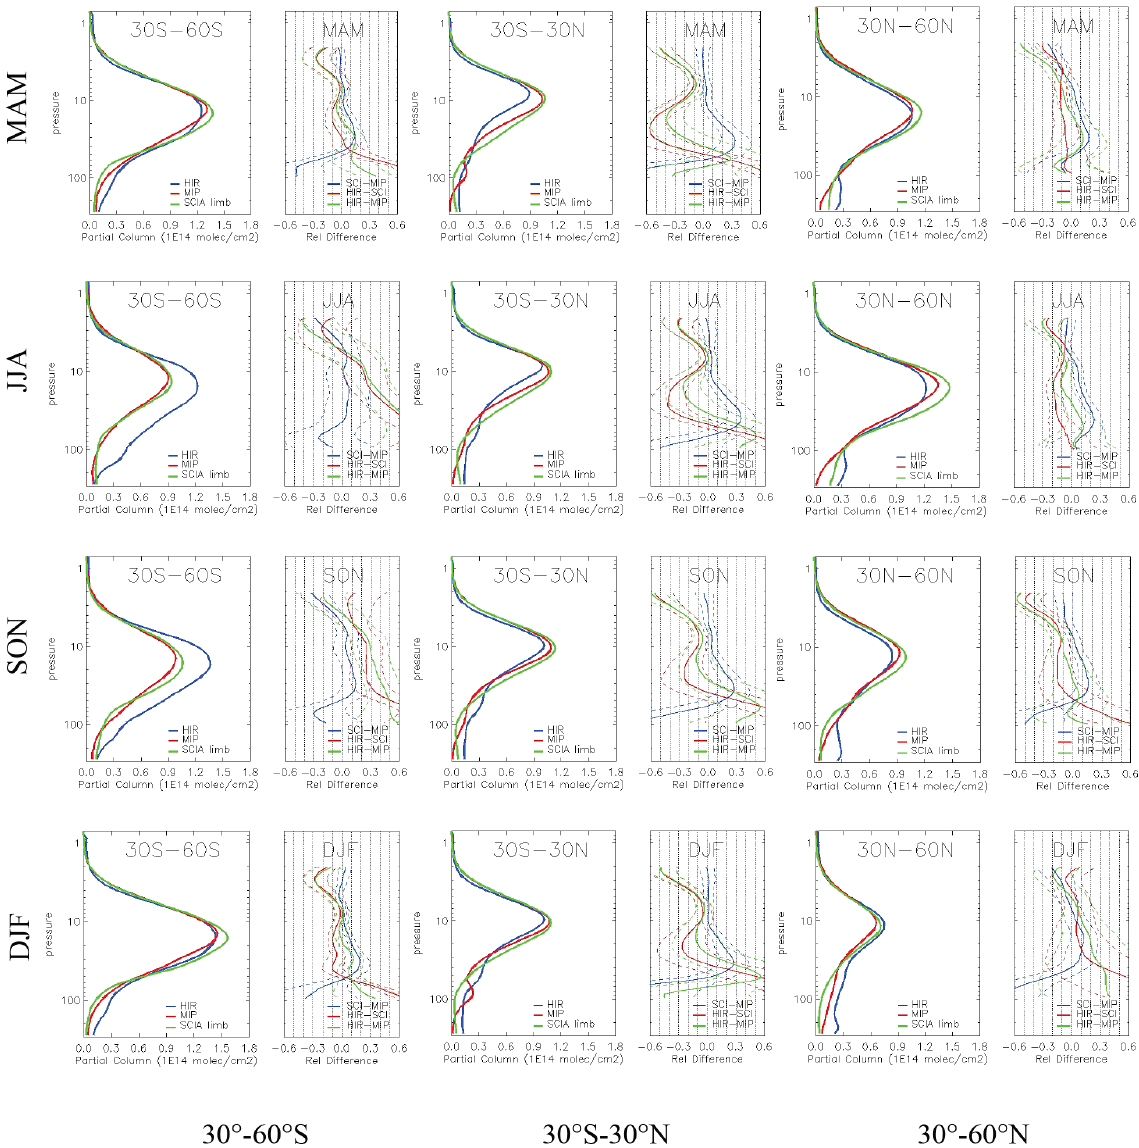
Figure 5. Partial column NO 2 profiles from HIRDLS (blue), MIPAS (red) and SCIAMACHY limb (green): means and mean relative differ- ences over different latitude sectors (SH in the first column, tropical in the second column and NH in the third column) and seasons (MAM in the first row, JJA in the second row, SON in the third row and DJF in the fourth